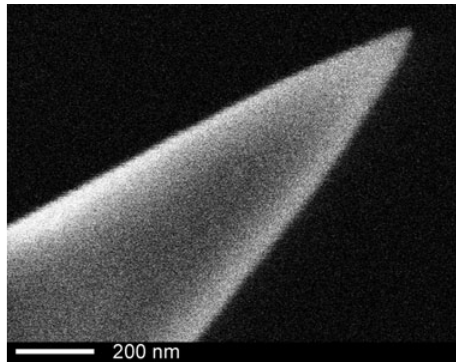
Figure 9 Solid apertureless scanning probe with a tip dia- meter of ∼ 20 – 30 nm etched from a gold wire. Image courtesy